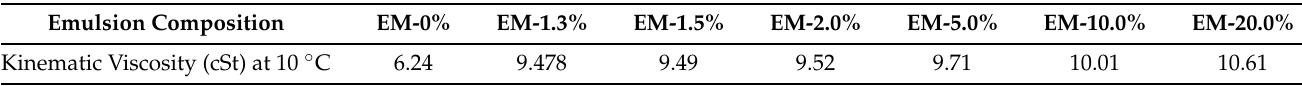
Table 2. Viscosity of different W/D emulsion compositions.